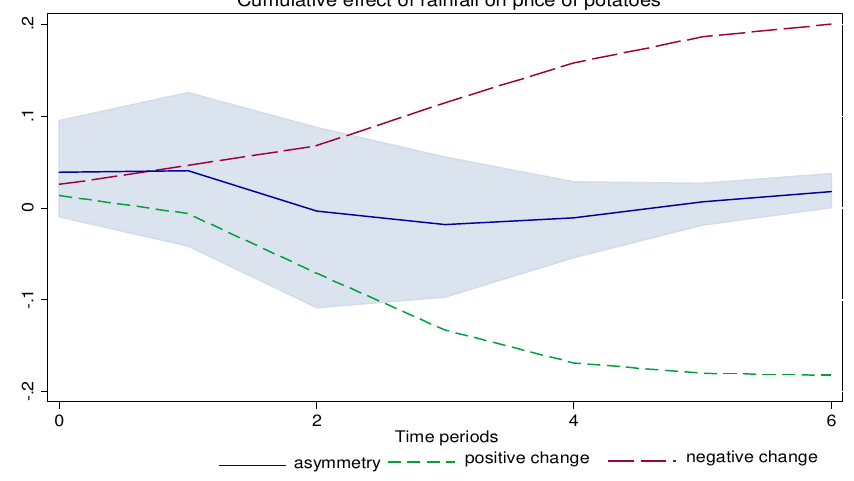
Fig. 5. Dynamic multipliers. Effect of rainfall on potato